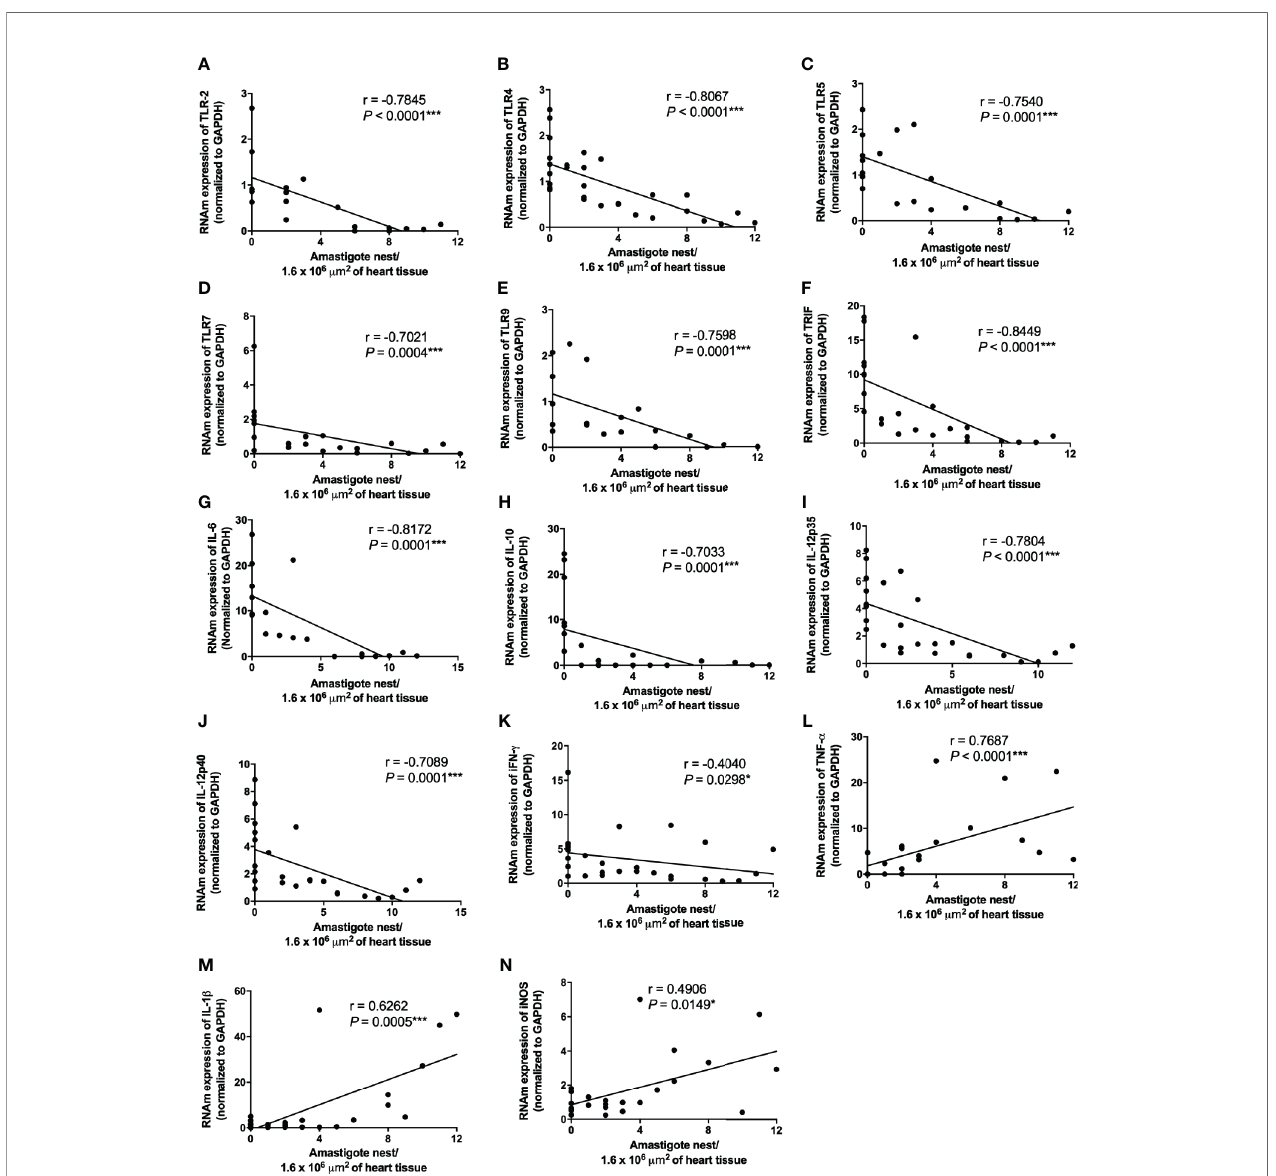
FIGURE 6 | Low TLR2, TLR4, TLR5, TLR7, TLR9, TRIF, IL-6, IL-10, IL-12p35, IL-12p40, IFN- g and high TNF- a , IL-1 b , iNOS mRNA expression in cardiac tissue are correlated with high Trypanosoma cruzi virulence. The mRNA expression levels of TLR2 (A) , TLR4 (B) , TLR5 (C) , TLR7 (D) , TLR9 (E) , TRIF (F) , IL-6 (G) , IL-10 (H) , IL-12p35 (I) , IL-12p40 (J) , IFN- g (K) , TNF- a (L) , IL-1 b (M) , and iNOS (N) were determined by real-time PCR in cardiac tissue from Swiss mice infected by the intraperitoneal route with 1 × 10 4 blood trypomastigote forms of T. cruzi strains that showed low (AM64 + 3253) (n=10), medium (PL1.10.14 + CL) (n=10), and high (Colombian + Y) (n = 10) virulence. The expression levels were normalized to the expression level of GAPDH. The results are expressed as the means ± standard errors and Spearman test was used. * p < 0.05; *** p <